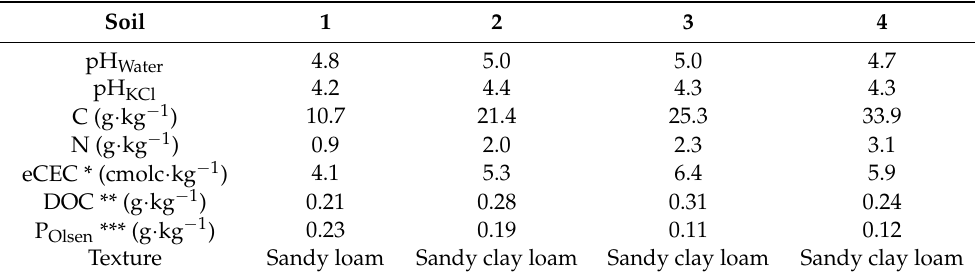
Table 1. Properties of the four soils studied in the laboratory experiment (adapted from Conde-Cid et al. [1]).